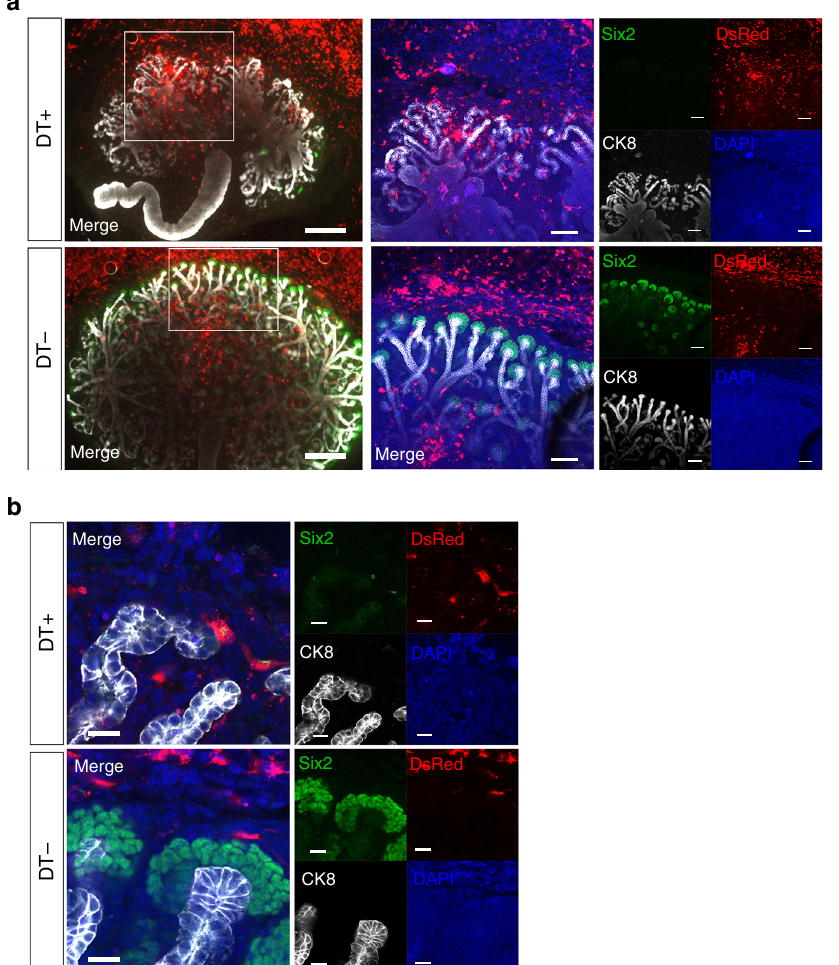
Fig. 6 Examination of regeneration of nephron progenitor cells using exogenous fi broblasts which is not nephron progenitor cells. a DsRed fi broblasts were transplanted into the nephrogenic zone of progenitor elimination model (Six2-iDTR mice, DT+).Neither adherence to the CM nor differentiation into Six2+ cells (upper column) was observed. As a control, DsRed fi broblasts were transplanted into the Six2-iDTR metanephros without DT (lower column). b High- magni fi cation images of a . a left, scale bars: 500 µ m; a right, scale bars: 100 µ m; b scale bars: 20 µ m; DT+: daily administration of diphtheria toxin, DT − : no administration of diphtheria